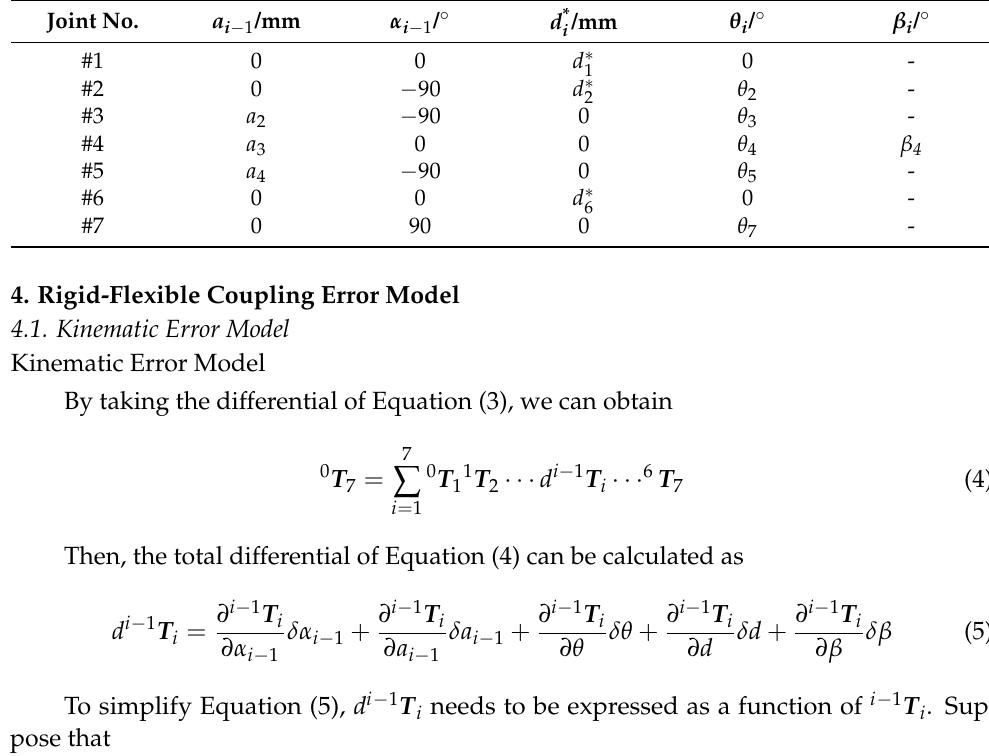
Table 1. MD-H parameters of the robot. Joint